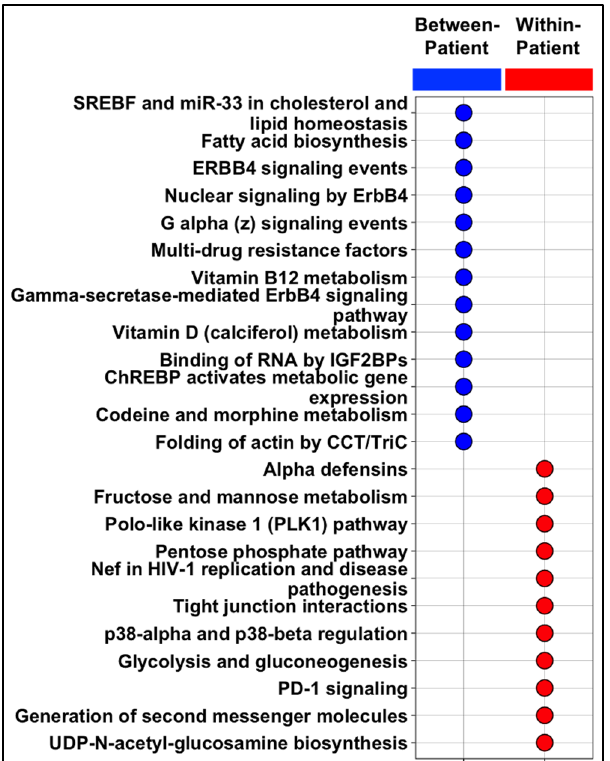
Figure 3. Enrichment analysis shows distinct pathways enriched in gene signatures with high regional ITH and intratumoral heterogeneity. Significant ( p < 0.05) enrichment of pathways from between-patient gene expression signature (blue, 108 genes) and within-patient signature (red, 183 genes).